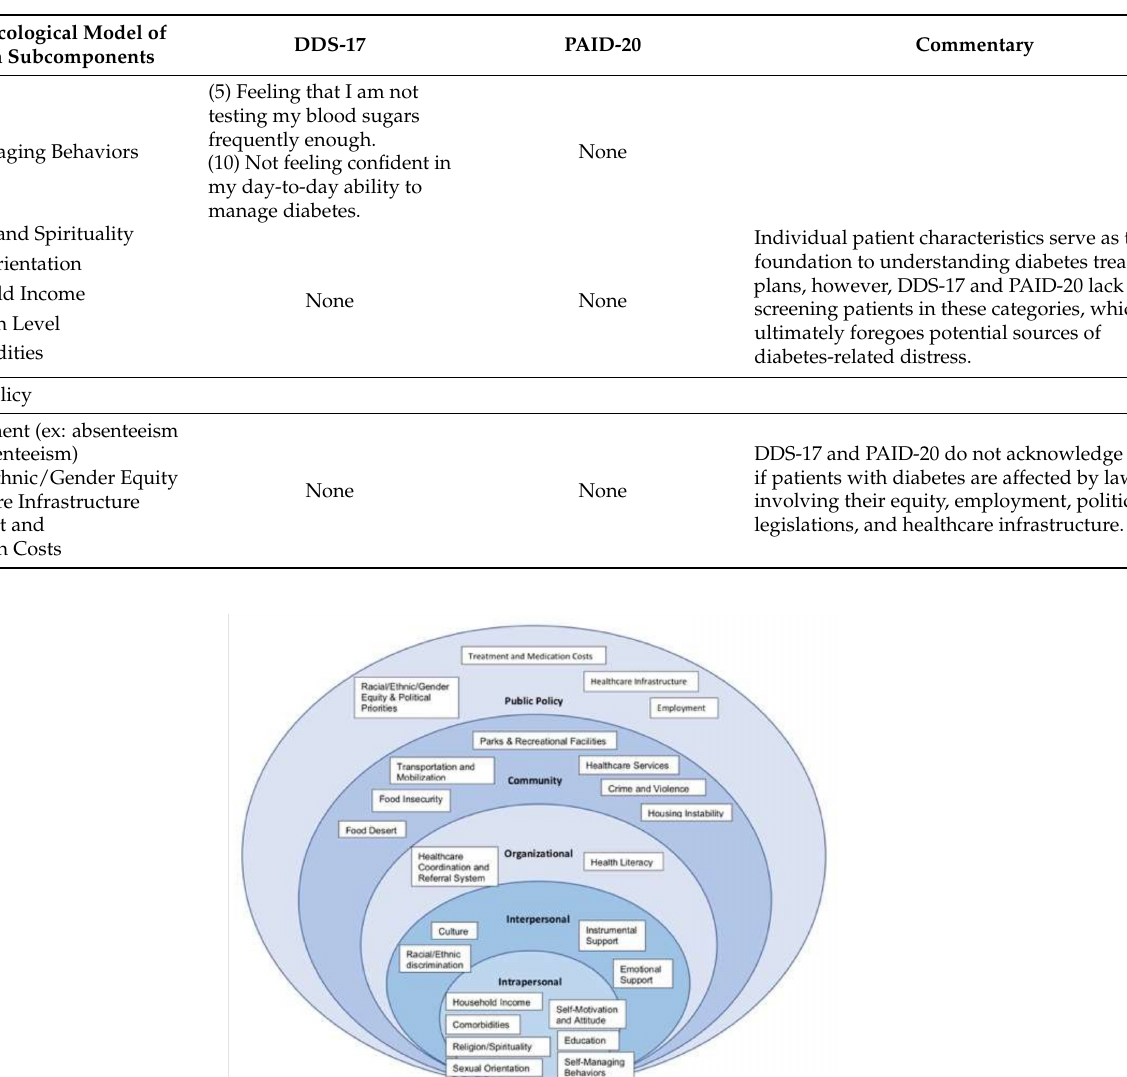
Figure 1. The social determinants of health represented within each sector of the socioecological model of